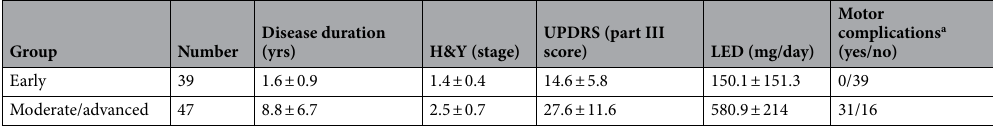
Table 1. Patient clinical characteristics. Abbreviations: H&Y = Hoehn & Yahr; UPDRS = Unified Parkinson’s Disease Rating Scale; LED = levodopa equivalent dose. a Wearing off and/or dyskinesia.